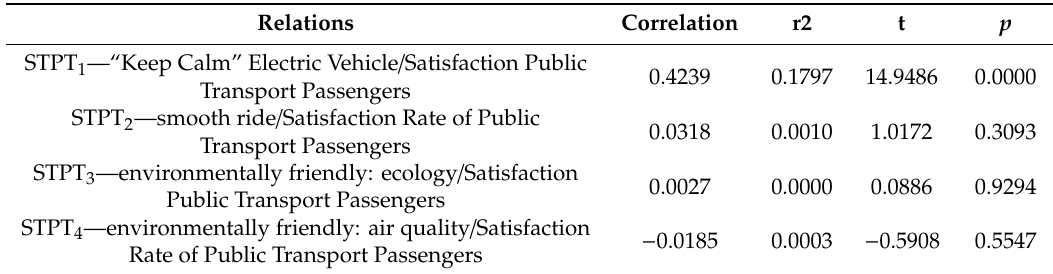
Table 4. Correlation analysis.